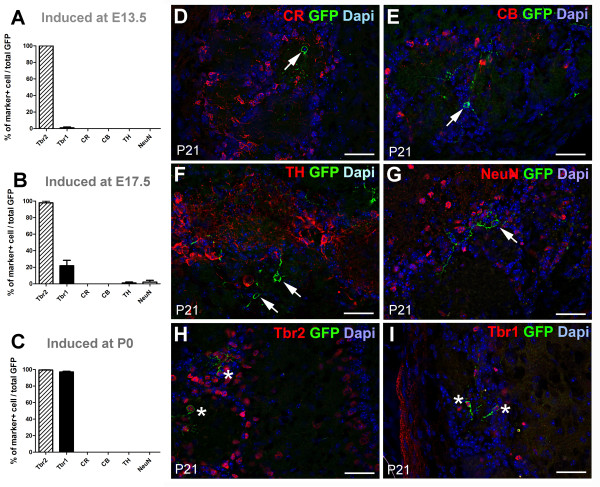
Ngn2 progenitors sequentially generate Tbr2- and Tbr1-expressing neurons during embryonic development. (A-C) Antigenic properties of Neurog2-derived OB juxtaglomerular neurons of P21 Ngn2CreERT2 × TaukiGFP mice. The recombination was induced at E13.5 (A), E17.5 (C) and at birth (E) by a single injection of tamoxifen. Error bars indicate S.E.M. (D-I) High field images of the pattern of expression of the markers used to identify subpopulations of juxtaglomerular OB neurons. All images were acquired from animals induced at birth and sacrificed at P21. Arrows point to cells negative for the markers tested. Asterisks indicate cells positive for Tbr2 and Tbr1. Scale bar: 50 μm in all panels. CB, calbindin; CR, calretinin; NeuN, neuronal nuclear antigen; Tbr1 and Tbr2, T-box protein 1 and 2; TH, tyrosine hydroxylase.